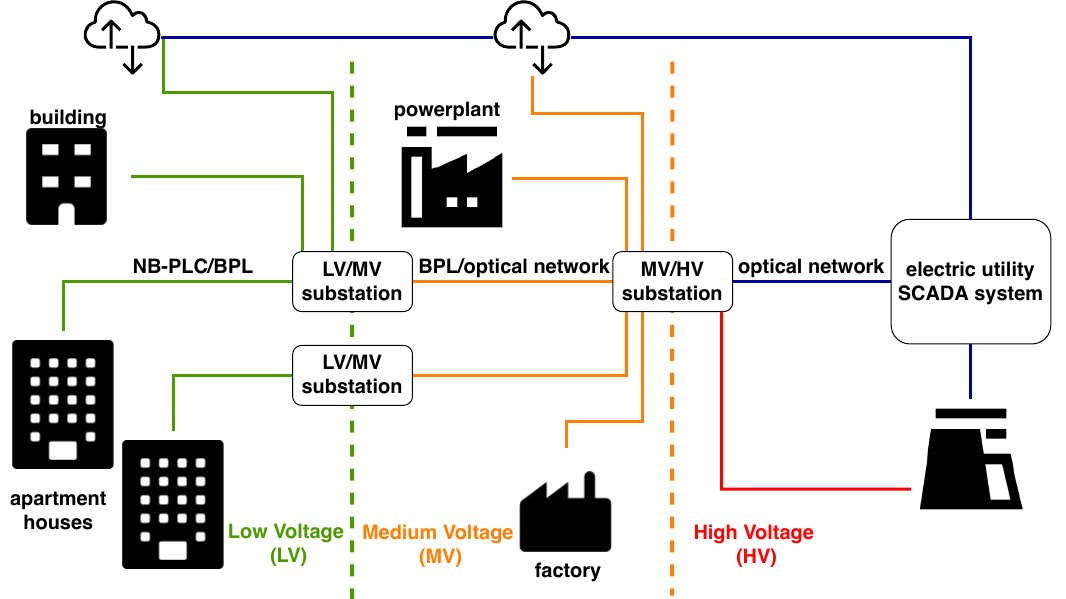
Figure 1. Power grid network with communication technologies typical for low voltage (LV), medium voltage (MV) and high voltage